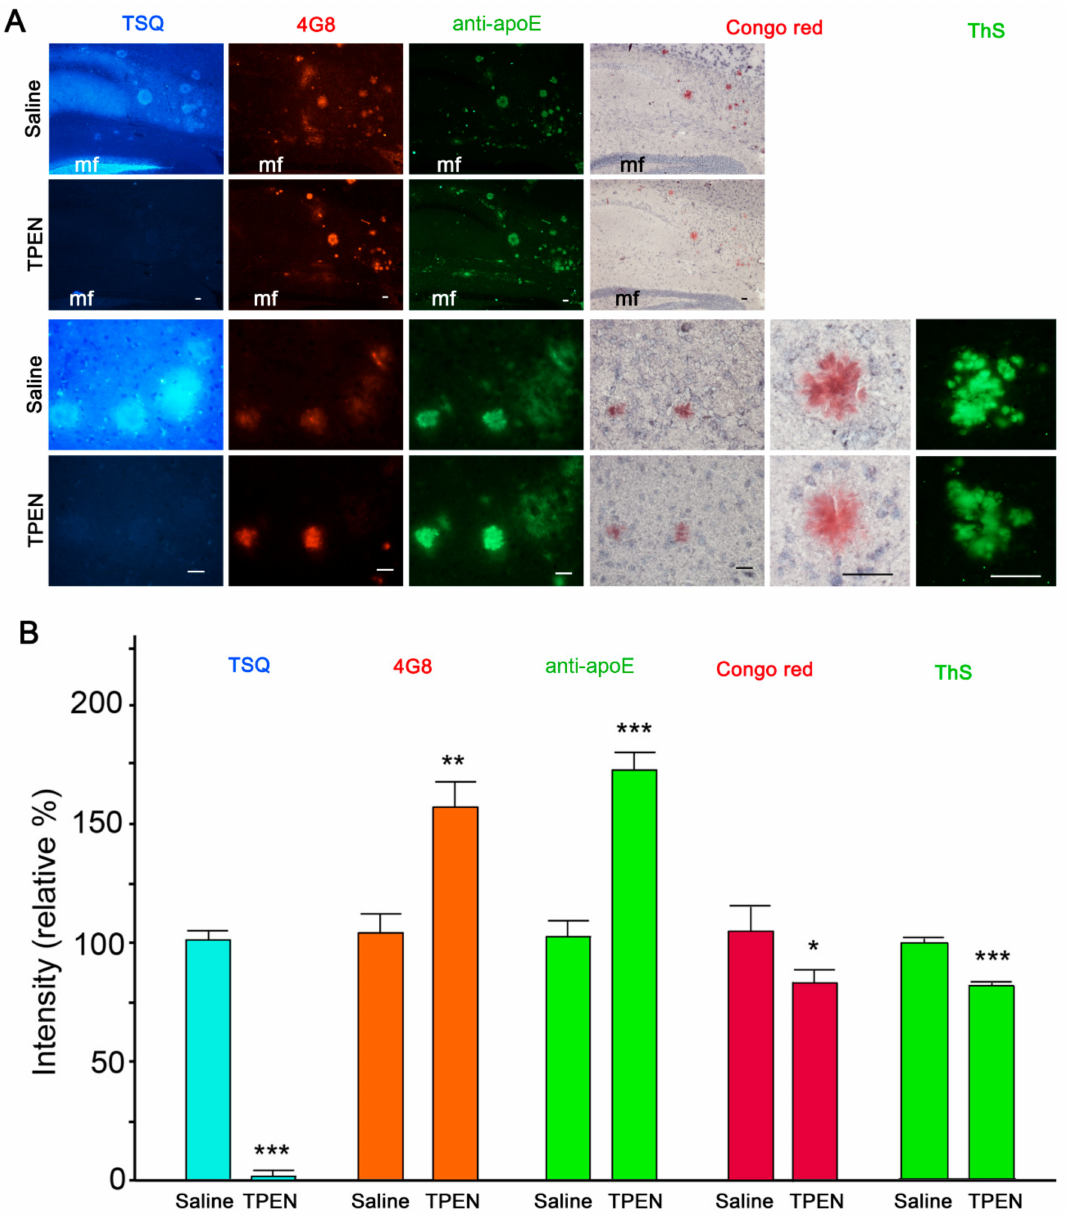
Figure 1. Amyloid- β (A β ) and apolipoprotein E (apoE) immunoreactivities in amyloid plaques after zinc chelation. ( A ) TSQ staining of zinc (blue in the first column), immunofluorescent staining of A β (4G8; red in the second column), apoE (green in the third column), Congo Red (pink in the fourth and fifth columns), and Thioflavin-S (ThS, green in the sixth column) staining of amyloid plaques in the brain of a Tg2576 mouse. The sections were treated with saline (first and third rows) or 100 µ M TPEN (second and fourth rows) for 5 min. The magnifications were 100 × (first and second rows), 400 × (third and fourth rows), and 1000 × (fifth and sixth columns), respectively. mf, hippocampal mossy fiber areas. Scale bars, 50 µ m. ( B ) Quantification of TSQ-positive zinc levels (blue), 4G8-reactive A β (orange), apoE (green), congophilicity (pink), and Thioflavin-S (ThS; green) staining intensity on amyloid plaques shown in (A). The quantitative comparisons were performed using 900 plaques in nine adjacent sections randomly selected from three Tg2576 mice per treatment. * p < 0.05, ** p < 0.01, and *** p < 0.001 by unpaired t